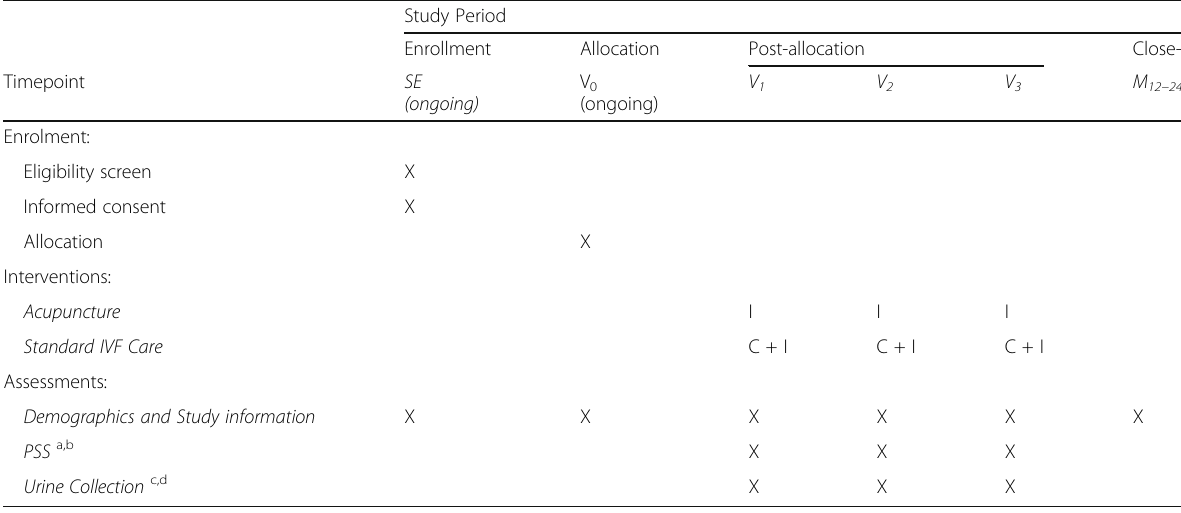
Table 1 The schedule of enrollment, interventions, and